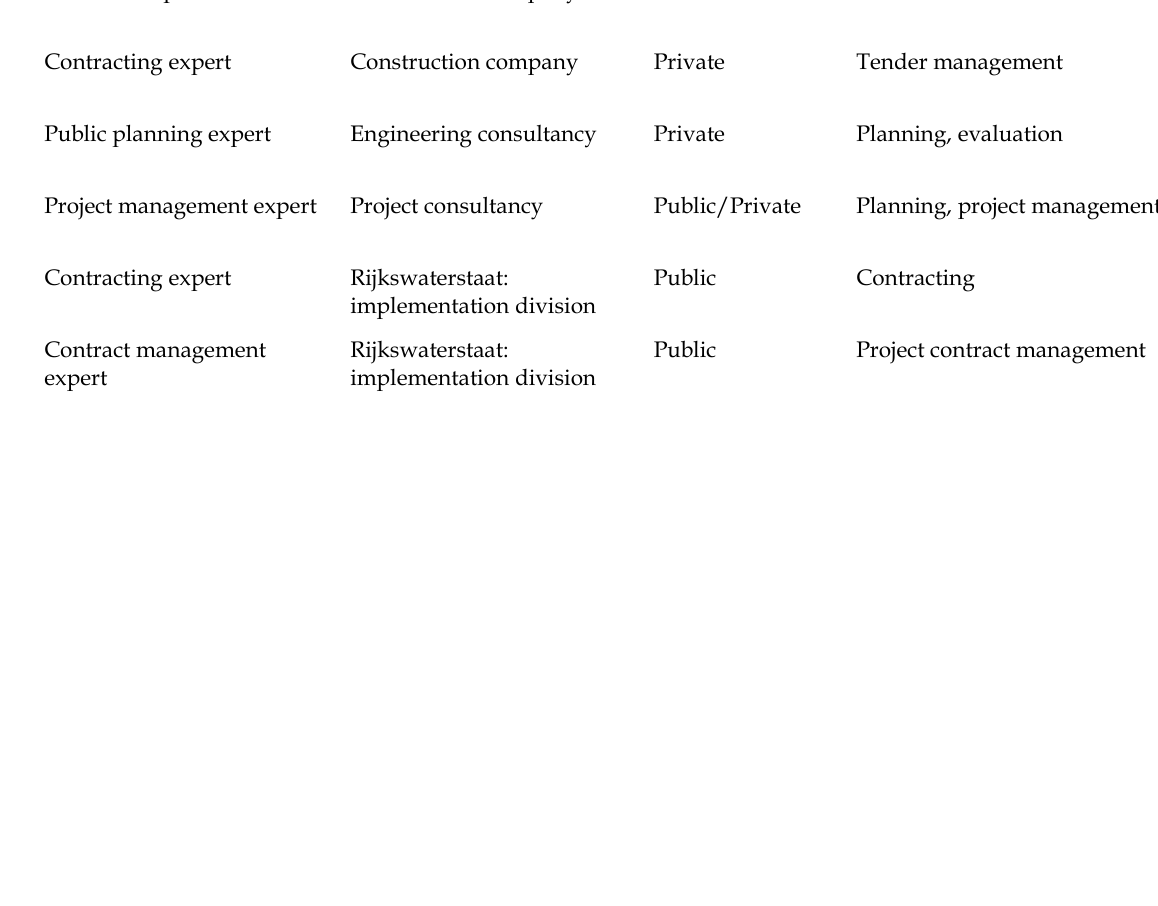
Table A2: Focus group 2